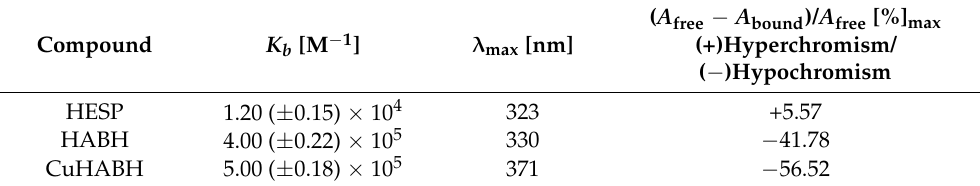
Table 2. UV–Vis spectral parameters of the interaction of HESP, HABH and CuHABH with CT DNA.